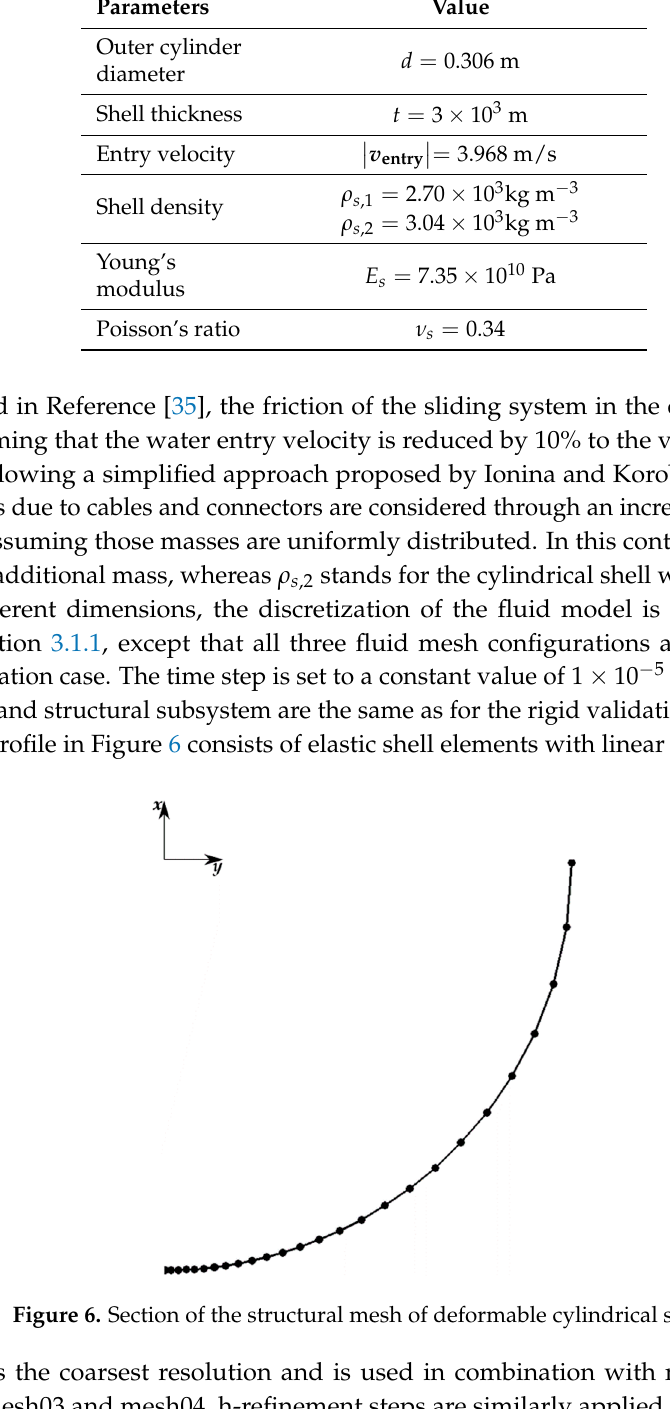
Table 2. Parameters of elastic validation case.